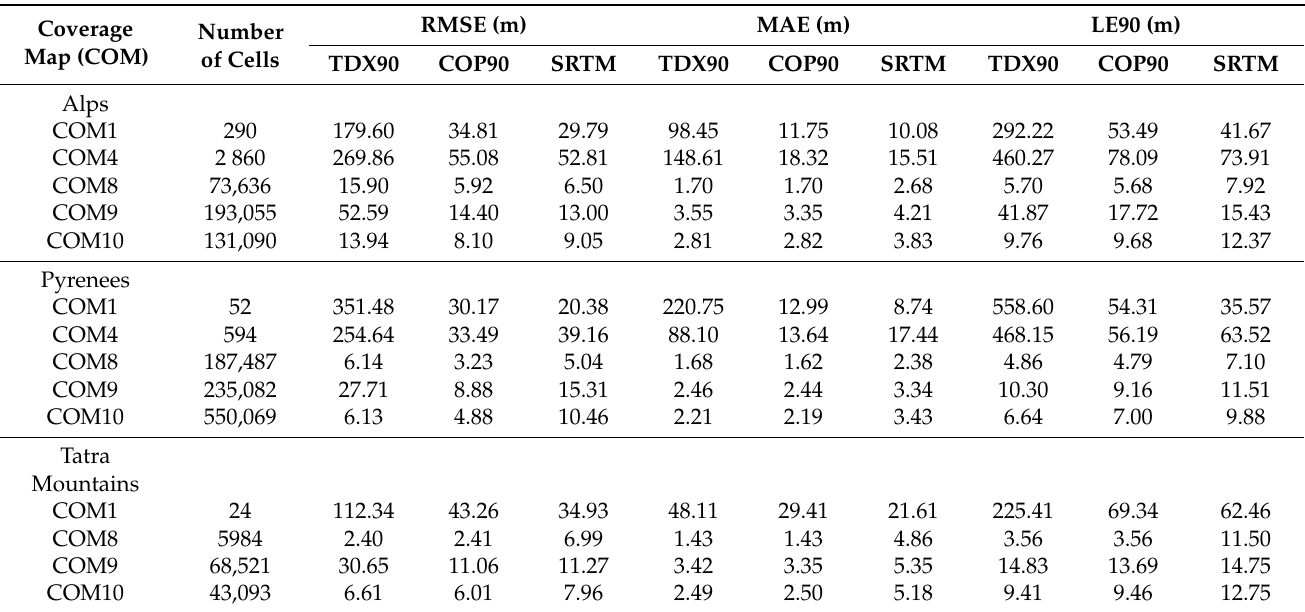
Table 3. Accuracy measures for TDX90, COP90, and SRTM90 with respect to the consistency mask (COM) in comparison with respective LiDAR DSMs. The classification of all the data into the COM categories was based on the TanDEM-X consistency mask. COM1: larger inconsistency, COM4: only one coverage, COM8: all heights are consistent, COM9: larger inconsistency but at least one consistent height pair, COM10: smaller inconsistency but at least one consistent height